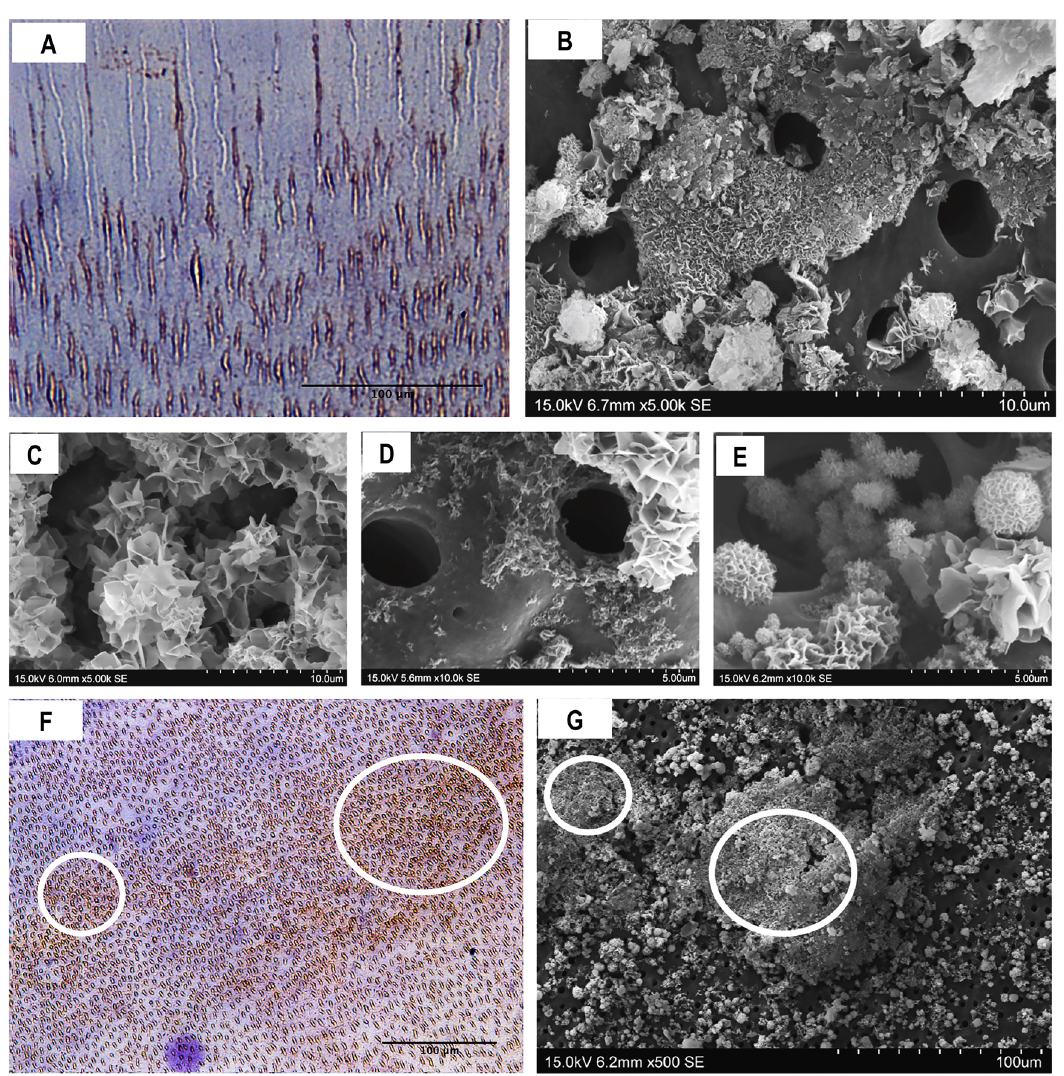
Figure 6. Functional relationship between NCPs and remineralisation of radicular dentin. ( A ) DMP1-CT immunoreactivity (40 × ). Scale bars, 100 µ m. ( B – E ) scanning electron microscopy (SEM) photomicrographs showing mineral formation at intratubular and peritubular dentin at early stages. ( F ) DSPP immunoreactivity (10 × ). Circles indicate areas of greater immunoreactivity, and ( G ) the SEM image shows similar higher mineral deposition in some areas. Circles indicate areas with high mineral deposition.